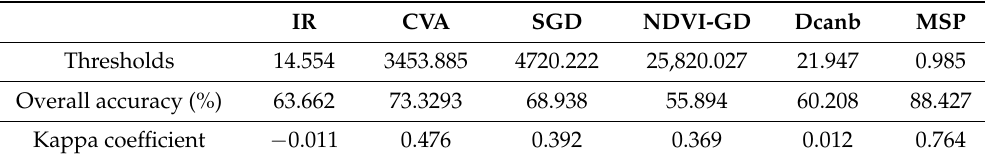
Table 3. The accuracies of the six change detection methods.